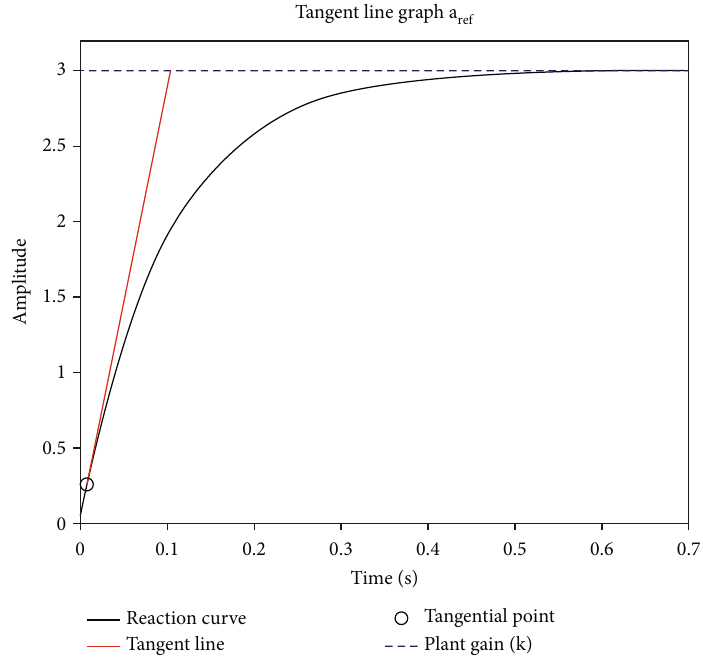
Figure 15: Reaction curve or a